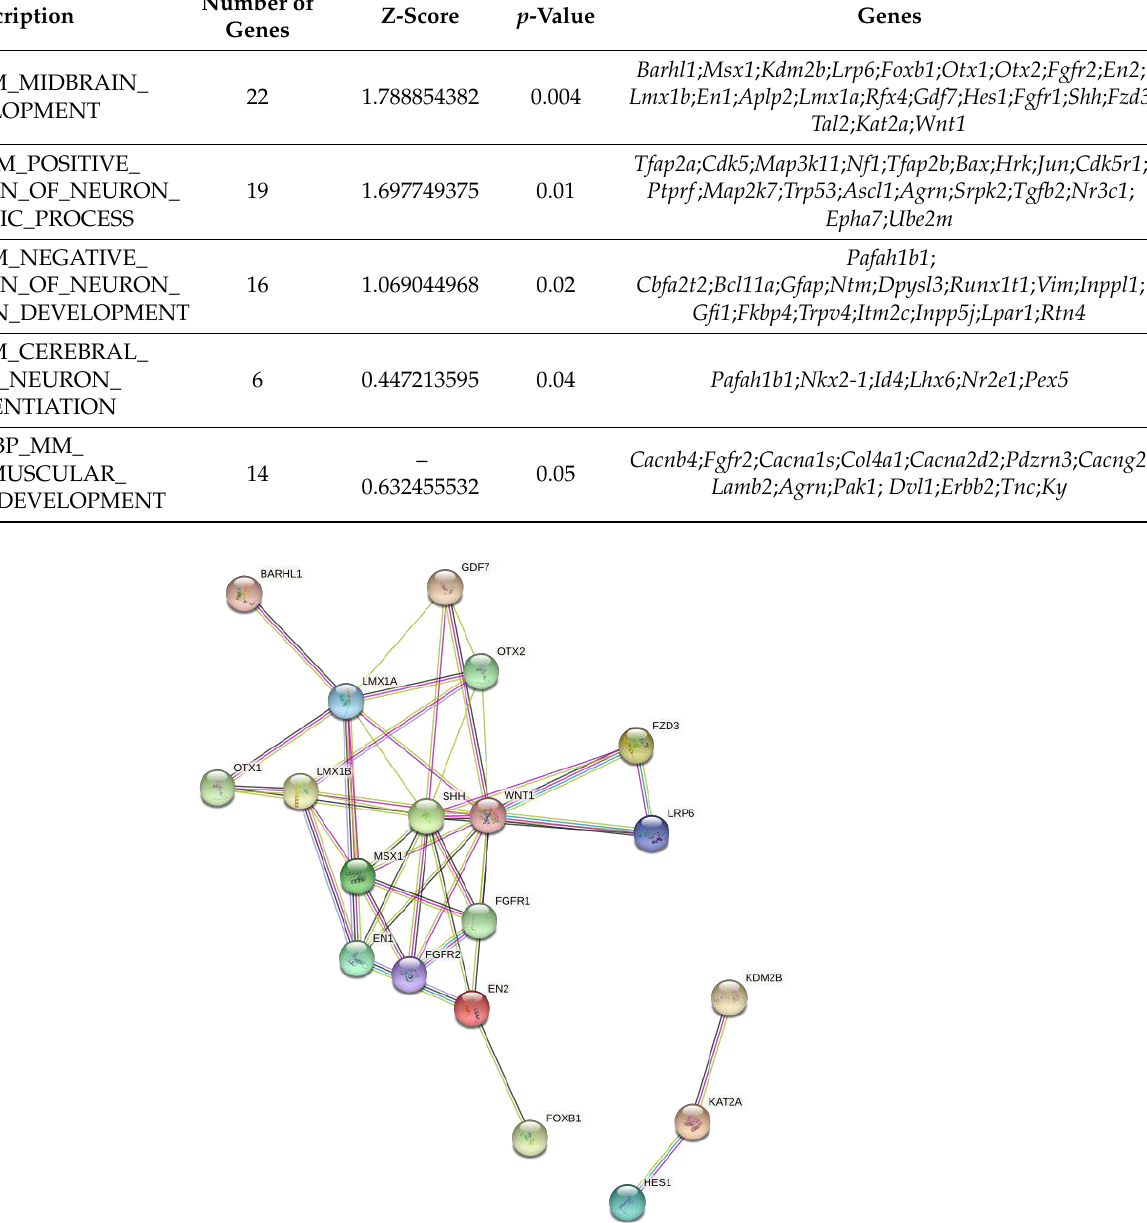
Figure 3. Protein–protein interactions network. Protein interactome network for the proteins that were shown to be differentially methylated in FXS-like mouse models compared to controls using the STRING software. All the colored nodes represent the query proteins and first shell of interactions. Each node represents all the proteins produced by a single, protein-coding gene locus. Filled nodes mean that the 3D structure of that protein is known or predicted. The colored lines represent different types of associations. The navy-blue line indicates known interactions from curated databases. The fuchsia lines indicate known interactions that are experimentally determined. The dark green lines represent predicted interactions of neighboring genes, the red lines represent gene fusions, and the royal blue line represents gene co-occurrence. The light green line represents text mining, the black line represents co-expression, and the purple line represents protein